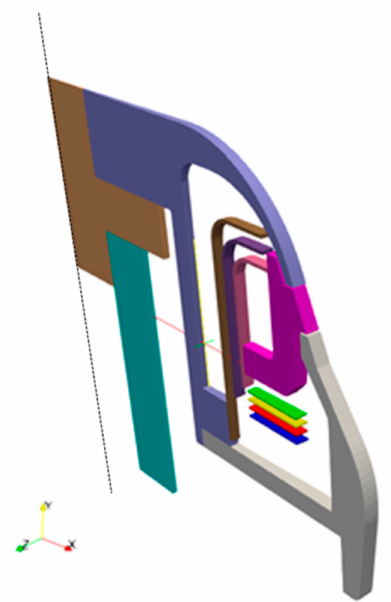
Figure 7. Scheme of the solution domain utilized for the FEM simulation. Each body is represented with a different color. The computational domain is represented as a wedge of 2 ◦ . The black dotted line represents the rotation symmetry